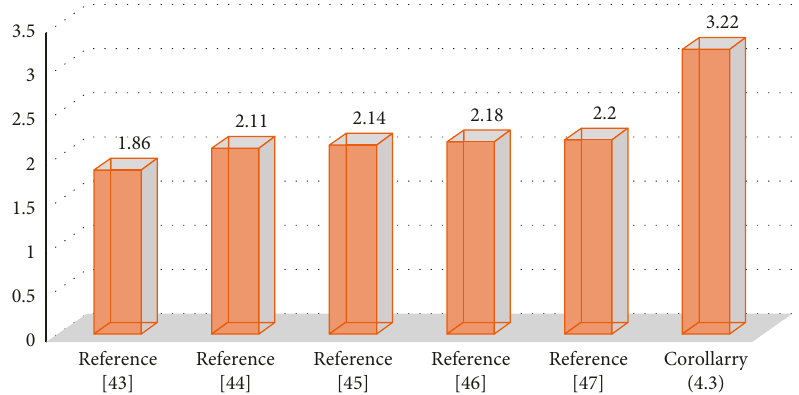
of Corollary 1 with references [39, 43, 44, 44, 46]. 1